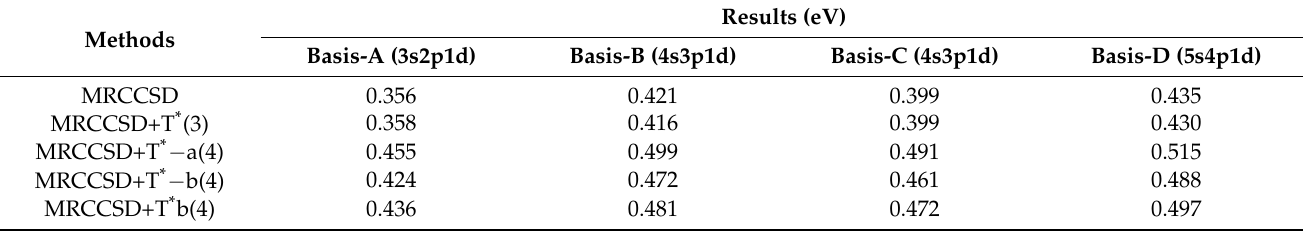
using various basis sets at inter-nuclear separation of 6.0 a. u. 2